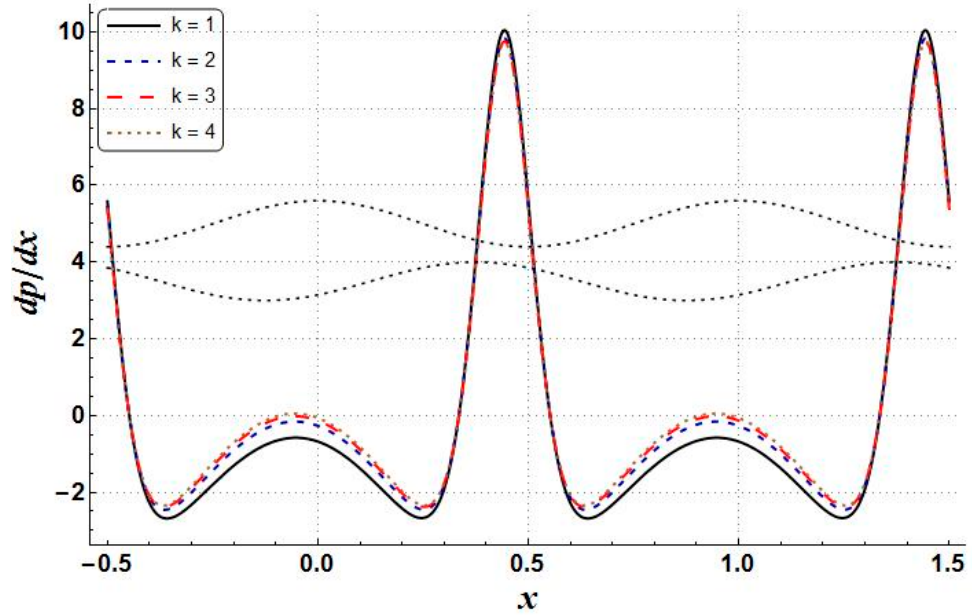
Figure 18. Influence on dp φ = 0.05, k = 2, a = 0.6, M = 1, d = 0.7, Br = 0.2, b = 0.5, ∈ = 2, η = 0.8.